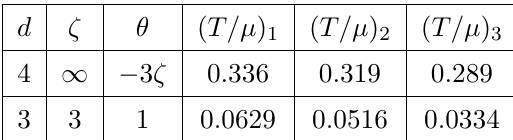
Table 4. For the strip in the solution of eq. (6.10) ( d = 4, (cid:16) = 1 , (cid:18) = (cid:0) 3 (cid:16) ) or eq. (6.11) ( d = 3, (cid:16) = 3, (cid:18) = 1), as ( T=(cid:22) ) decreases, at ( T=(cid:22) ) 1 a local minimum and maximum appear in (cid:27)=s as a function of LT , at ( T=(cid:22) ) 2 < ( T=(cid:22) ) 1 the local maximum becomes a global maximum, but the local minimum remains and still (cid:27)=s ! 1 (cid:0) as LT ! 1 , and then at ( T=(cid:22) ) 3 < ( T=(cid:22) ) 2 the local minimum disappears, and the transition occurs to (cid:27)=s ! 1 + as LT ! 1